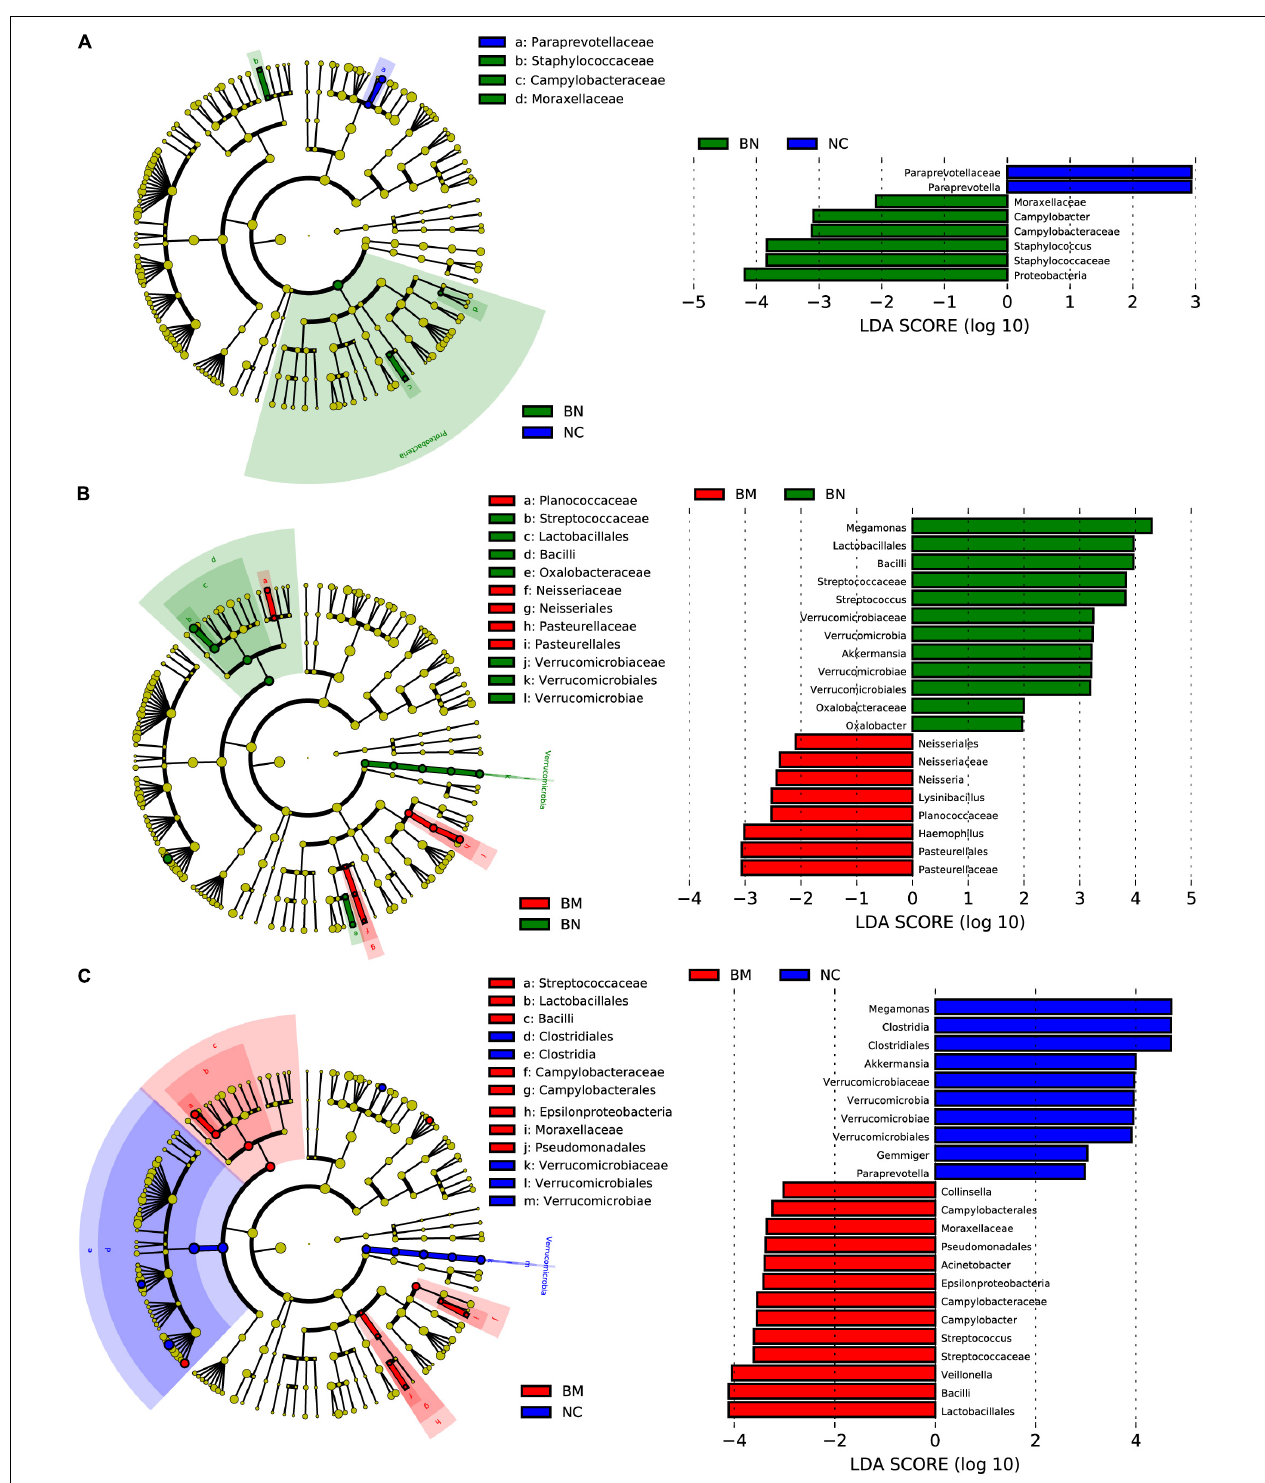
FIGURE 4 | LEfSe analysis identifies signature microbiota constituents that regulate breast cancer occurrence and bone metastasis. (A) Cladogram constructed with LEfSe indicating the significantly different taxa between NCs and BNs, and the bar plot shows the LDA score of the different taxa. (B) Cladogram constructed with LEfSe indicating the significantly different taxa between BNs and BMs, and the bar plot shows the LDA score of the different taxa. (C) Cladogram constructed with LEfSe indicating the significantly different taxa between NCs and BMs, and the bar plot shows the LDA score of the different taxa. LDA scores (log10) > 2 and P < 0.05 were considered significantly